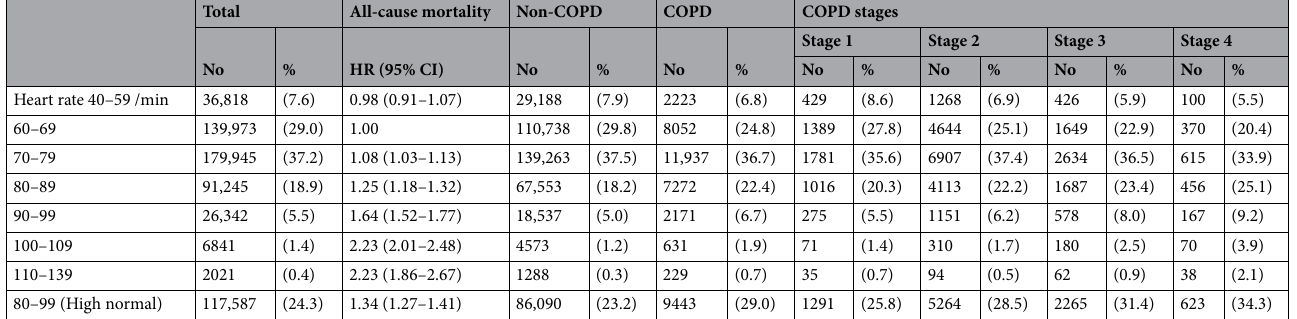
Table 2. Distribution of heart rate by COPD stages. Hazard ratios were adjusted for age, gender, education, BMI, smoking status, physical activity, anemia, blood pressure and blood